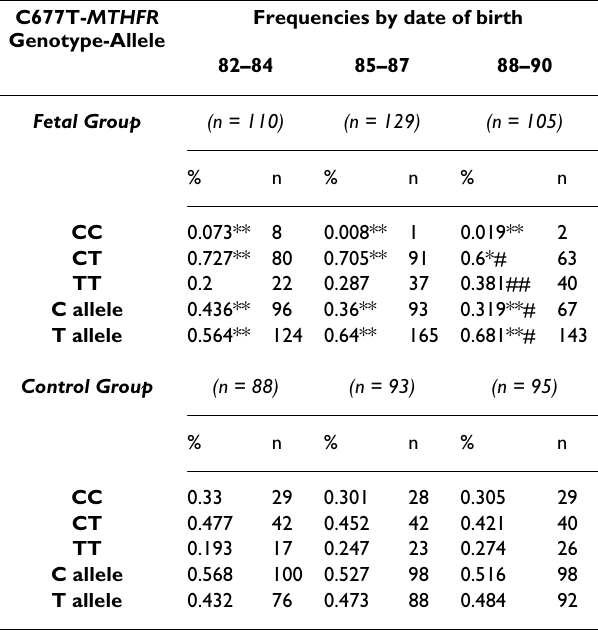
Table 2: Allelic and genotypic frequency comparison between fetal and control groups. C677T- MTHFR